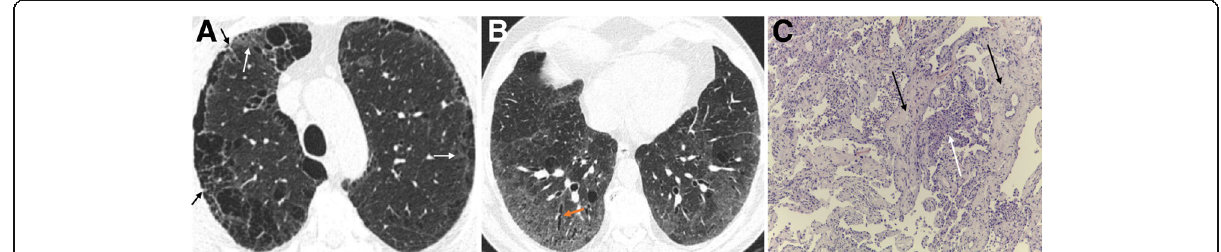
Fig. 19 AEF and DIP combined with fibrotic NSIP pattern. a Axial CT image through the upper lobes shows CLE and PLE, associated with reticulation (black arrows) and discrete patchy ground-glass opacities (white arrows). The areas of emphysema within the areas of GGO appear to have more well- defined walls, a finding termed as AEF. b Axial CT at the lower lobes shows GGO with scattered cystic changes, mild reticulation, and bronchiectasis (orange arrow), signifying underlying fibrosis. c Lung transbronchial criobiopsy with uniform thickening of alveolar septa by collagen deposition (black arrows), mild associated inflammation, emphysema, and respiratory bronchiolitis (white arrow) (H&E, ×100)